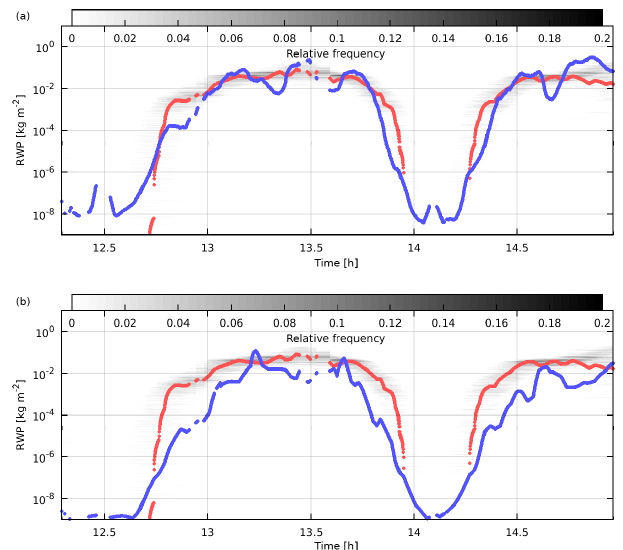
Figure 10. (a) Time series of the retrieved RWP. The time series of the retrieved RWP is shown as a blue line. The time series of the ICON model RWP for the time and location of the FAAM during flight B897 is shown as red line. Time series of histograms of the ICON model RWP are plotted as grey shades underneath; see text for details. (b) The same as in (a) , but the RWP is retrieved from the simulated